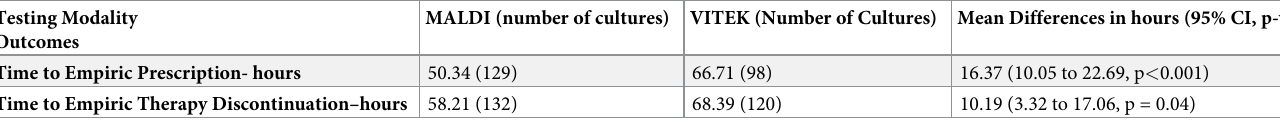
Table 3. Time to empiric prescriptions and discontinuation of empiric therapy- MALDI vs. VITEK � . Testing Modality Outcomes Time to Empiric Prescription- hours